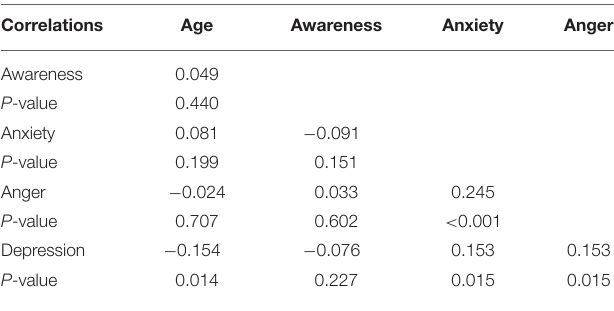
TABLE 2 | Spearman Rho correlation of age, awareness, anxiety, and anger on COVID-19 amongst low-income Ugandans. Correlations